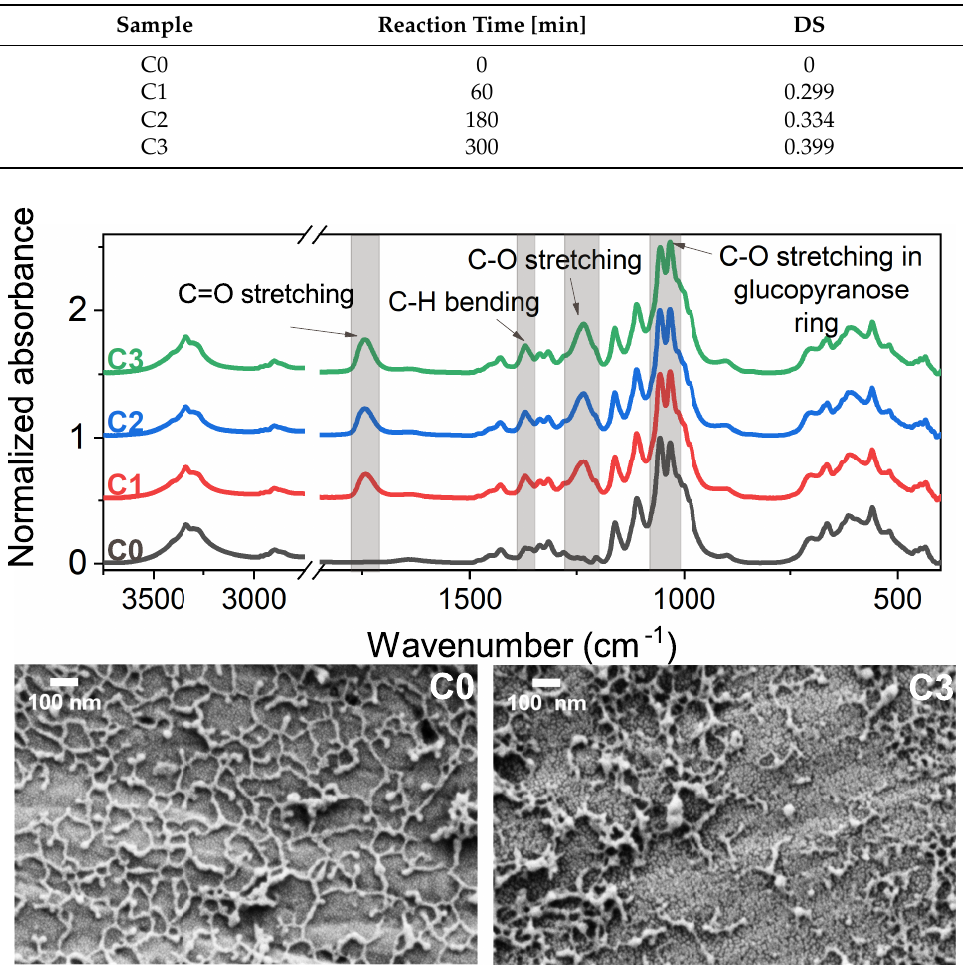
Figure 2. FTIR–ATR spectra of acetylated CNCs with C0 denoting the pristine material, C1, C2 and C3 representing samples with reaction time 1 h, 3 h and 5 h, respectively (upper part) and SEM micrographs of pristine (C0) and modified (C3) CNCs (lower